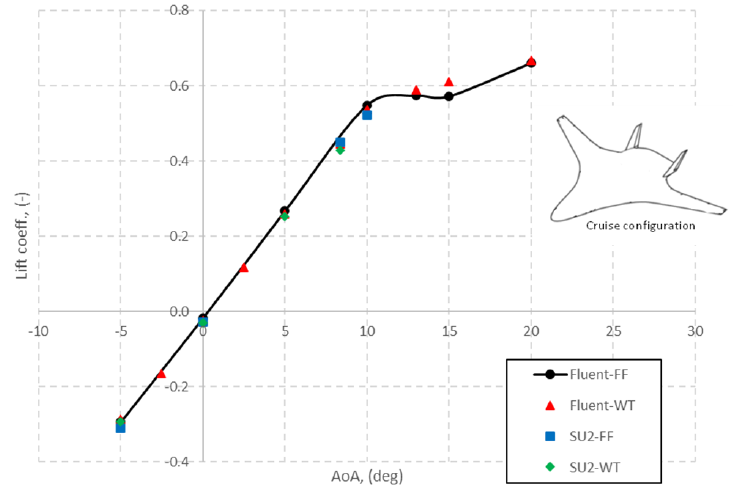
Figure 20. Lift coefficients versus AoA, effect of the Reynolds